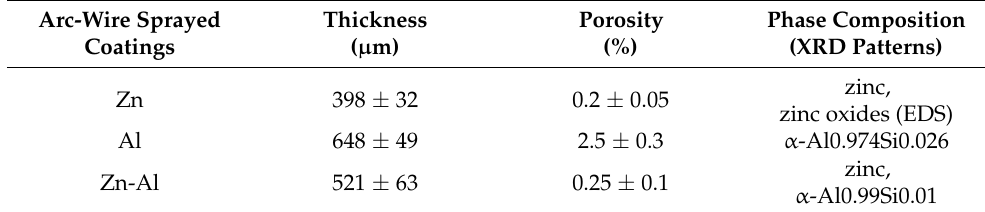
Table 4. Properties of obtained arc sprayed